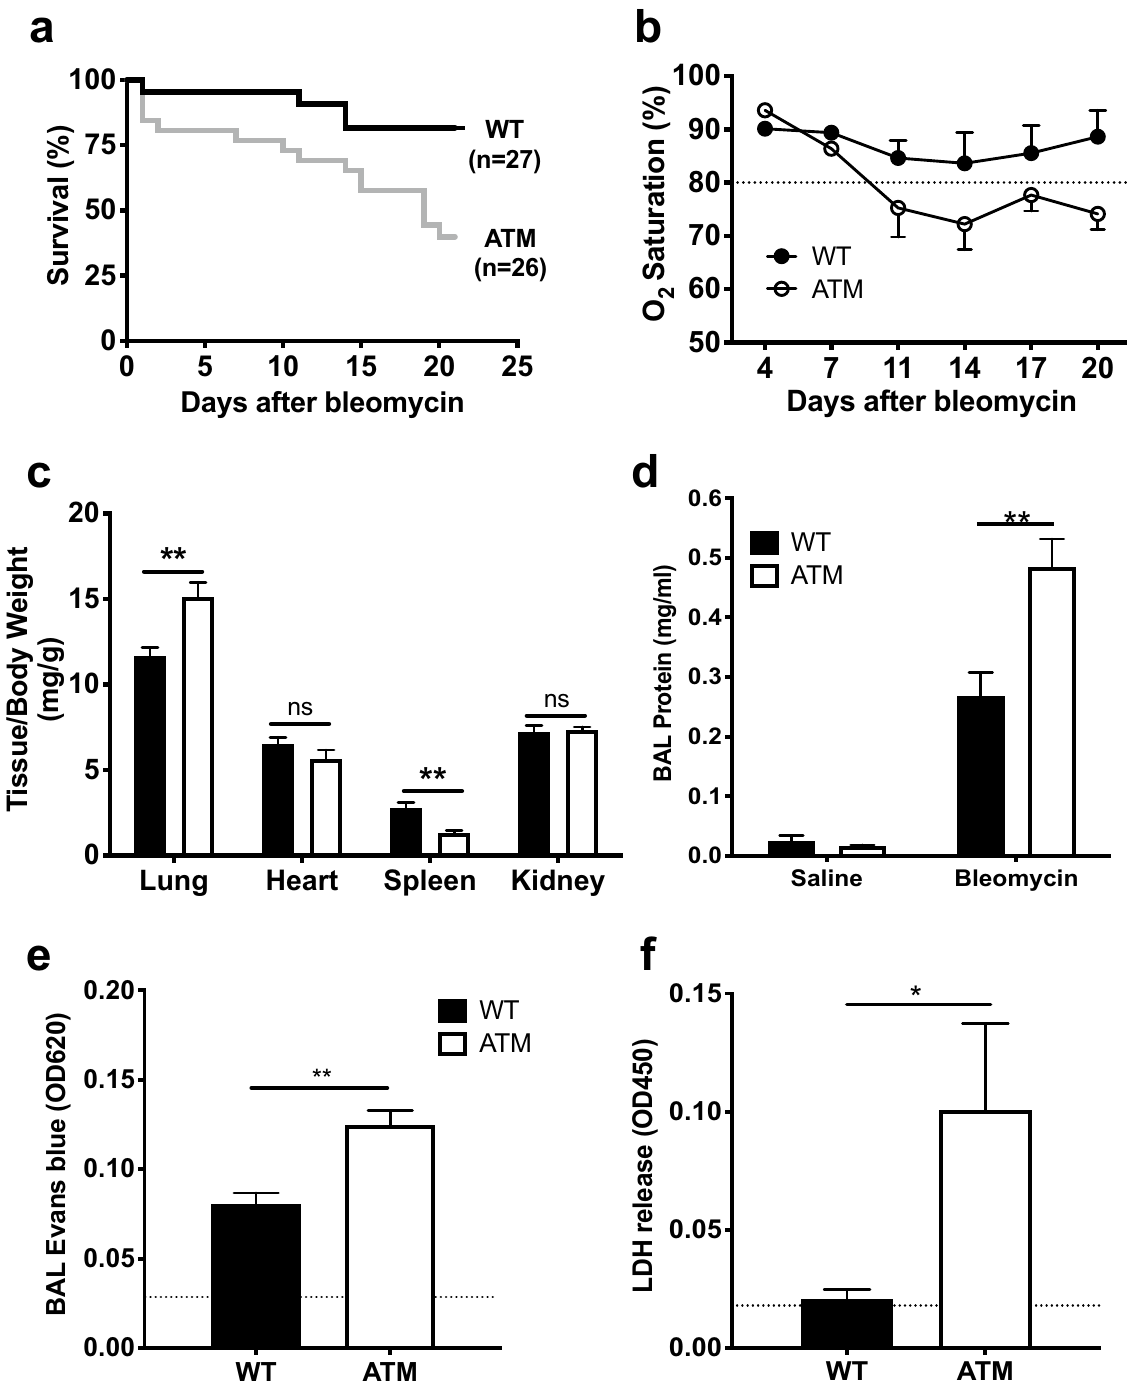
Figure 1. ATM-deficiency causes decreased survival and exacerbates lung injury upon bleomycin instillation. ( a ) Kaplan–Meier survival plot of ATM ∆/∆ and WT mice instilled with 0.025U bleomycin. Survival was determined up to 21 days post-instillation (p = 0.006, log rank test). ( b ) Arterial oxygen saturation (%) was measured in conscious, unrestrained and non-sedated mice at the indicated days post-bleomycin administration. Dotted line, 80% O 2 saturation, lower values indicate a state of severe hypoxia. ( c ) Ratios of wet weights of the indicated organs (mg) to total body weights (g) of bleomycin instilled mice were determined. ( d ) Protein concentrations (mg/mL) of the BALs were determined using the Bradford assay. ( e ) As a measure of vascular leakage, Evans blue dye (50 mg/kg) was injected via the tail vein and levels of dye in BAL fluid were quantitated after 3 h (A620). Dotted line, Evans blue levels in BAL fluid of saline-treated control animals. ( f ) Levels of released lactate dehydrogenase (LDH) in BAL fluid were assessed by the LDH-cytotoxicity assay (Roche). Dotted line, LDH in BAL fluid of saline-treated control animals. WT mice, black bars; ATM ∆/∆ mice, white bars. Each experiment was performed on a minimum of 5 animals from at least 2 independent experiments at d21 post-bleomycin instillation. Bars, mean ± SEM. *P ≤ 0.05; **P ≤